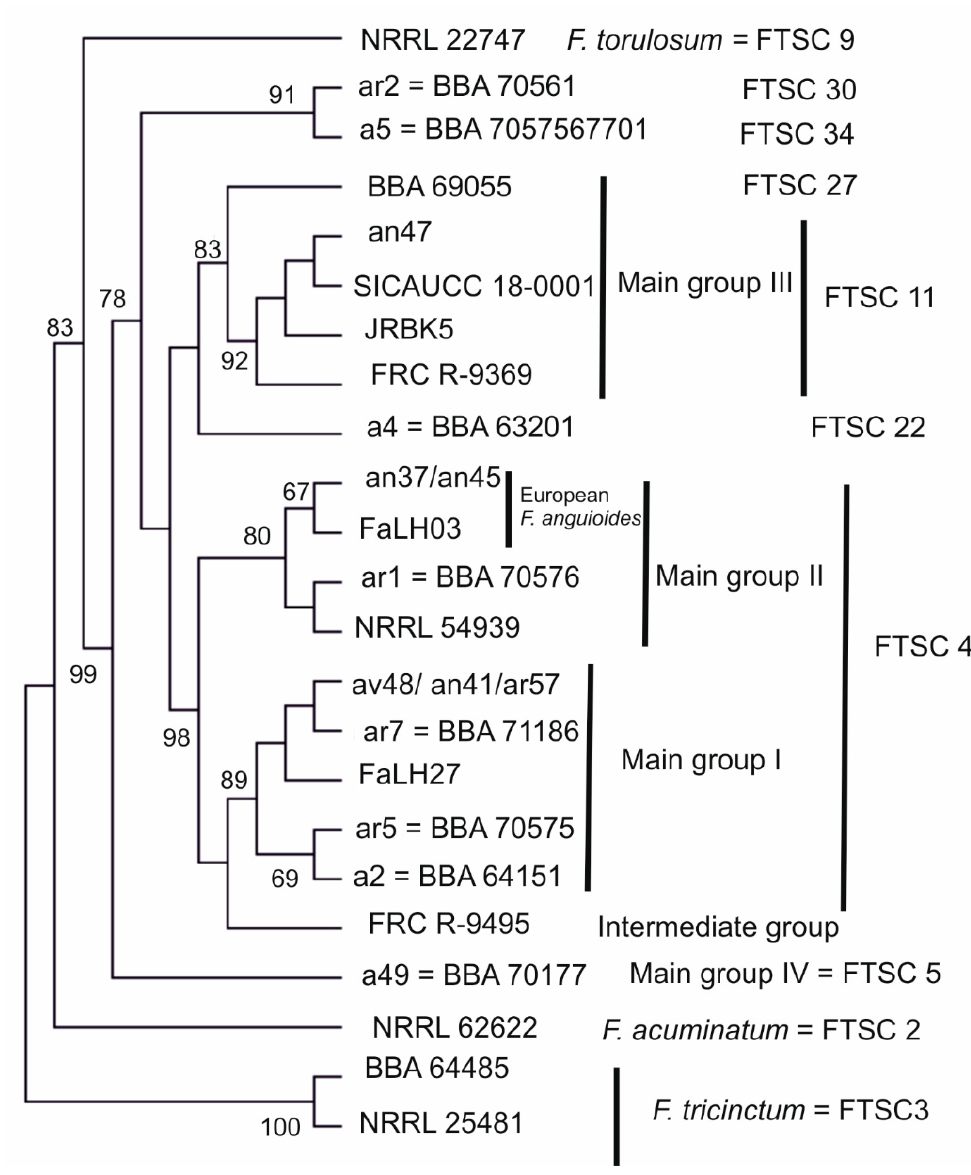
Figure 5. Maximum-parsimony consensus tree for combined translation elongation factor 1-alpha ( TEF1 ) and TUB2 sequences. Bootstrap values are indicated above nodes based on 500 pseudorepli- cates of the data. Only branches present in more than 50% of the trees are shown. Fusarium tricinctum and F. acuminatum strains are outgroups.